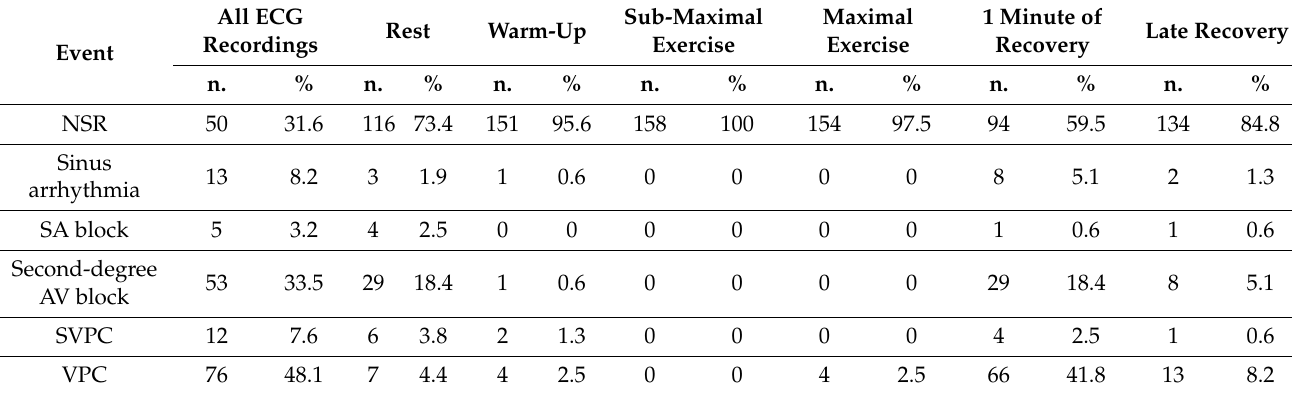
horses in which the event was recorded.